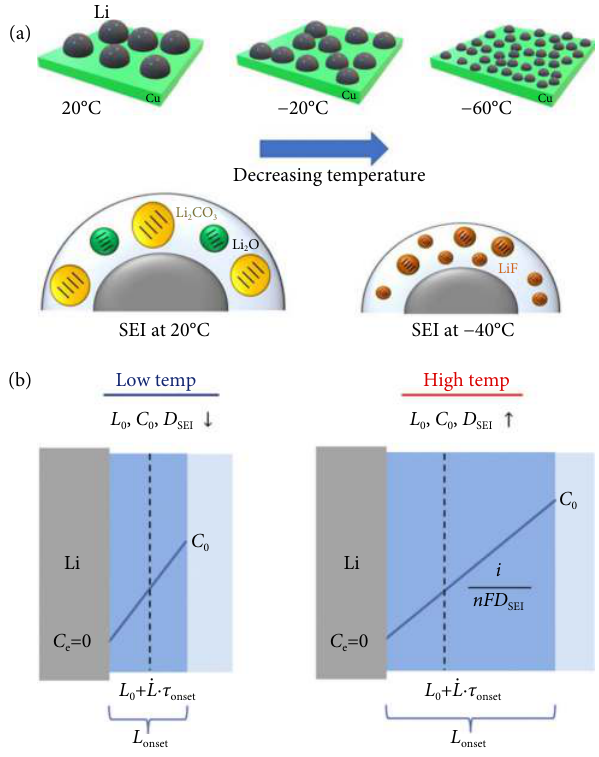
Fig. 6 Temperature dependence of SEI features as well as their impacts on the Li diffusion kinetics within SEI and Li deposition behaviors. ( a ) The structure and chemistry of SEI formed at 20 and −40 o C in an ether-based elec- trolyte and their corresponding Li deposition behaviors (reprinted with per- mission from Ref. [41], © 2019 American Chemical Society). ( b ) The effectf temperature on the variation of SEI thickness and initiation of Li dendrites (re- printed with permission from Ref. [87], © 2020 The Author(s)